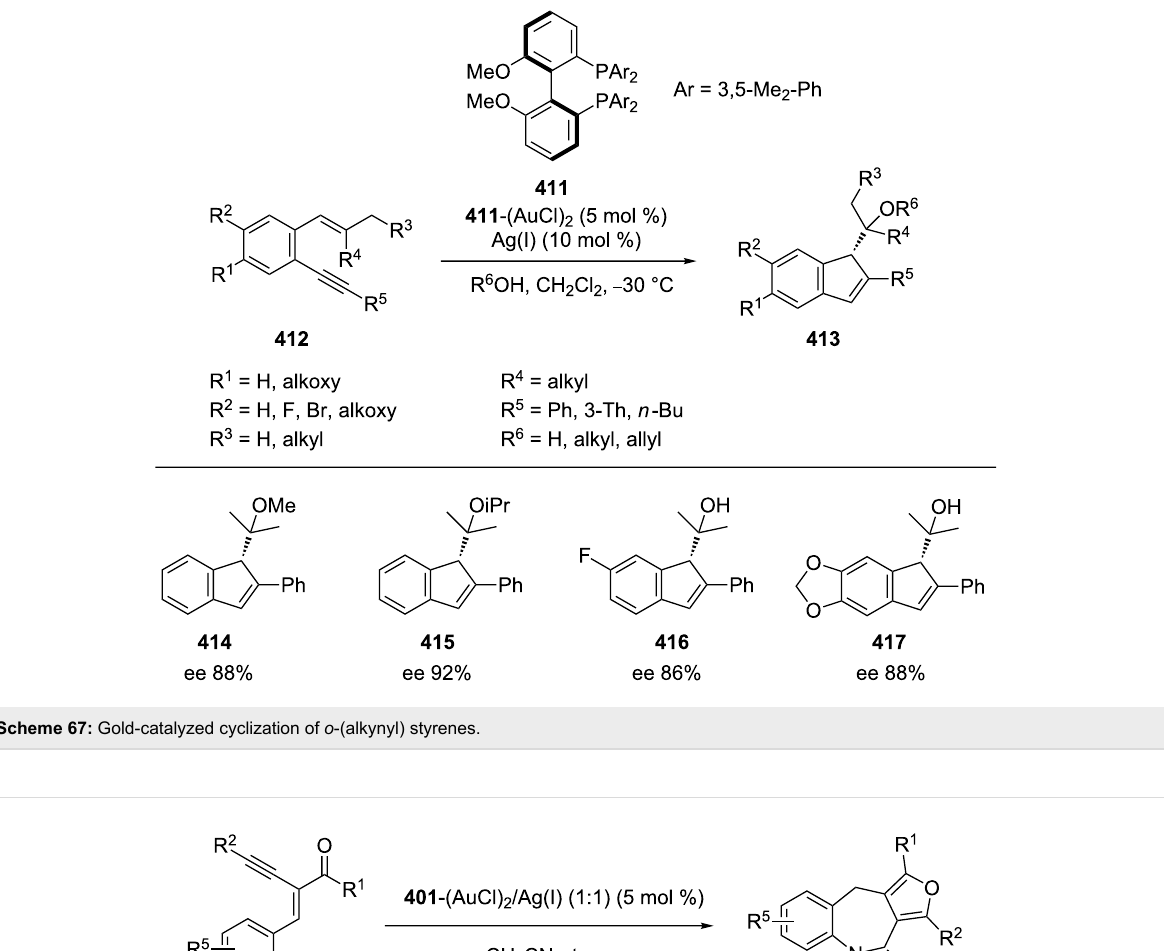
Scheme 67: Gold-catalyzed cyclization of o -(alkynyl) styrenes.